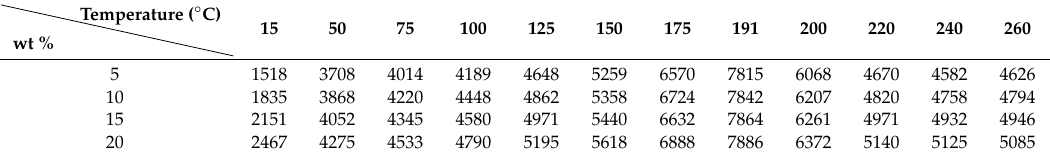
Table 4. Specific heat capacity of composite materials with di ff erent carbon contents.